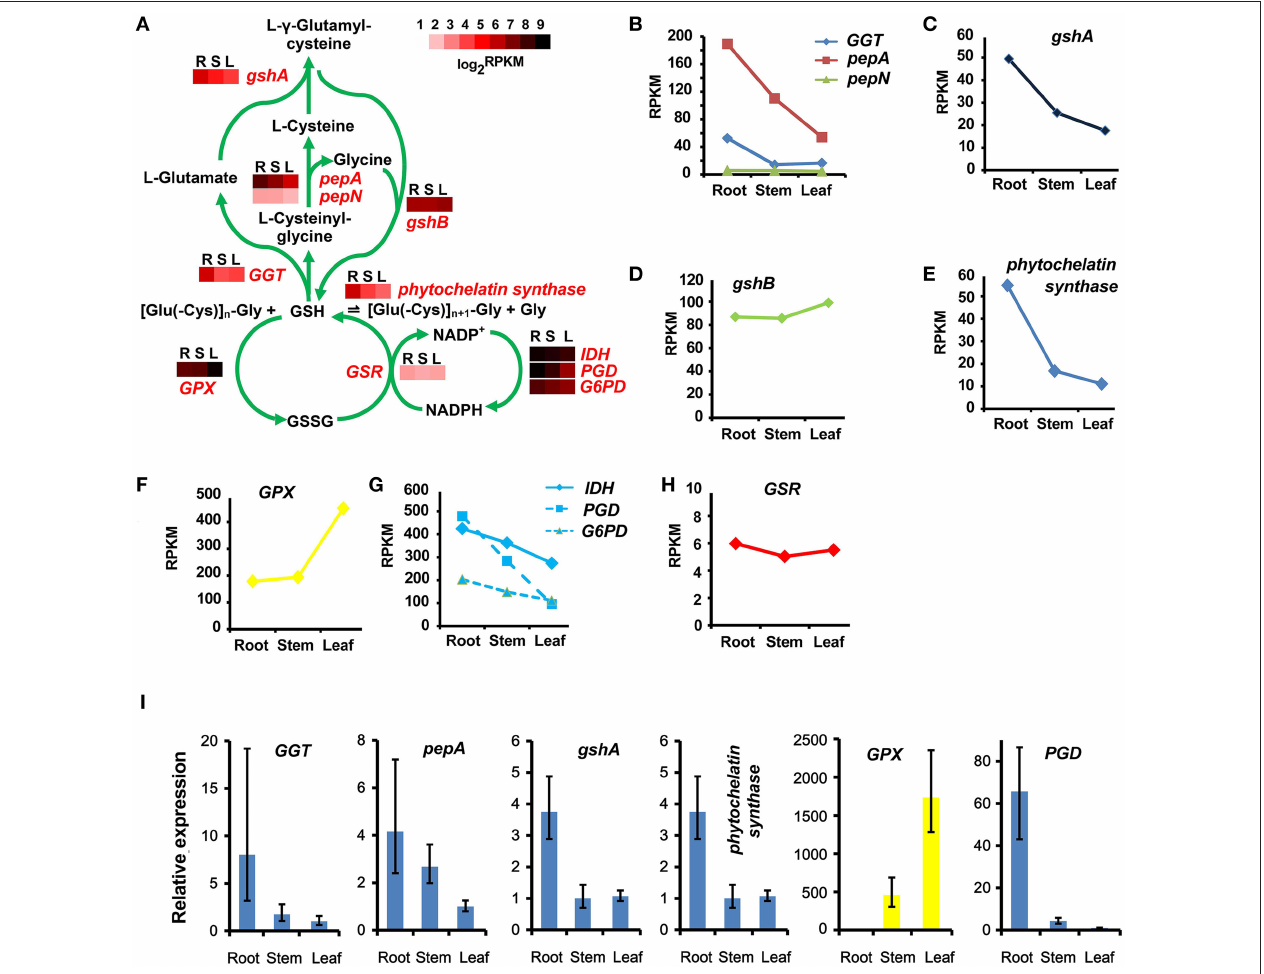
FIGURE 9 | Glutathione and phytochelatin synthetic pathways and their tissue patterns in Sinapis alba . (A) The glutathione cycling and phytochelatin synthetic pathway map with heatmaps showing the expression levels of the corresponding enzymes. R, root; S, stem; L, leaf. (B–H) Line charts showing the gene expression levels based on RNA-seq. (I) qPCR results. Bars indicating SDs of three biological and two technical replicates. GGT, gamma-glutamyl transferase; pepA, leucyl aminopeptidase; pepN, aminopeptidase; gshA, γ -glutamylcysteine synthetase; gshB, glutathione synthetase; GPX, glutathione peroxidase; IDH,